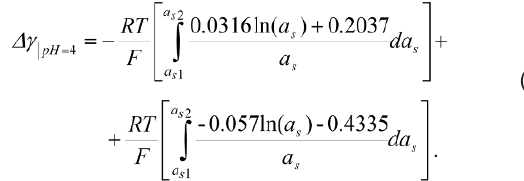
Figure 4. Change of interfacial excess energy of AgI due to KNO due to NaCl 2 activity change at a constant activity of Ag+ ions (pAg). pAgpzc =